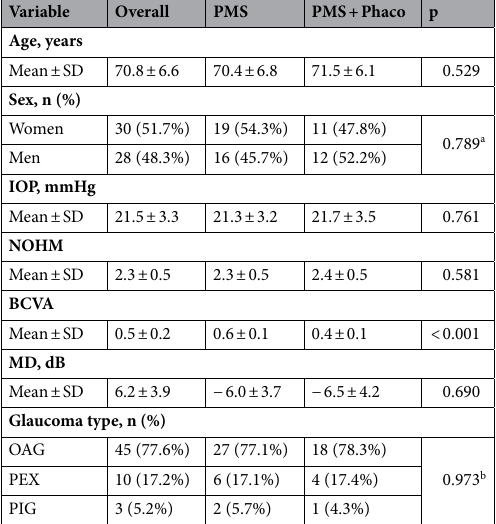
Table 1. Main demographic and clinical characteristics of the study sample. p values were calculated with Mann–Whitney U test. a Fisher exact test. b Chi-squared test. N number of eyes, SD standard deviation, IOP intraocular pressure, NOHM number of ocular hypotensive medications, PMS Preserflo Microshunt, BCVA best corrected visual acuity, MD mean defect, OAG open-angle glaucoma, PEX pseudoexfoliative glaucoma, PIG pigmentary glaucoma.